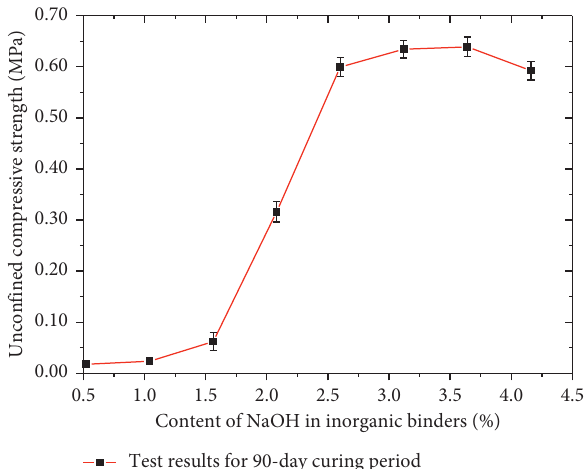
Figure 12: Influence of NaOH content in inorganic binders on UCS of sample during 90 d curing